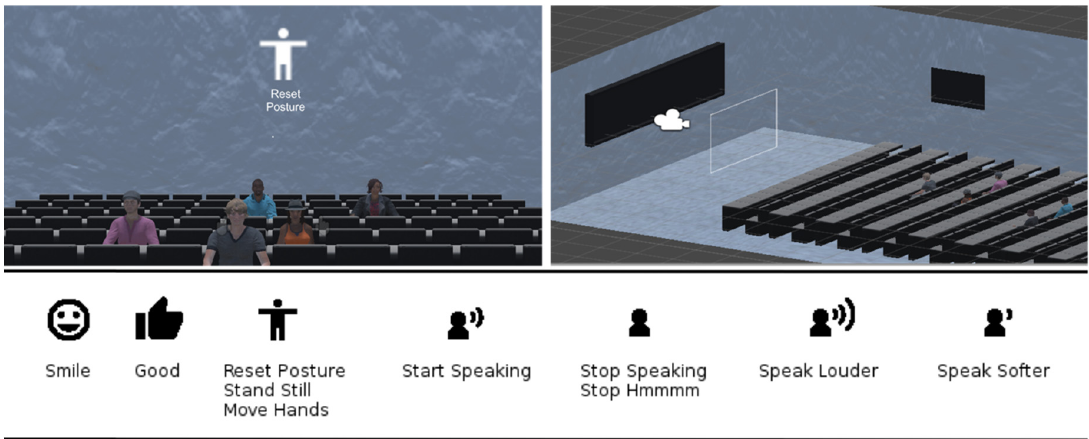
Figure 1. Top Left: User view while receiving Reset Posture instruction. Top Right: 3D Model of the classroom. Bottom: Feedback instructions used by the virtual reality (VR) module.